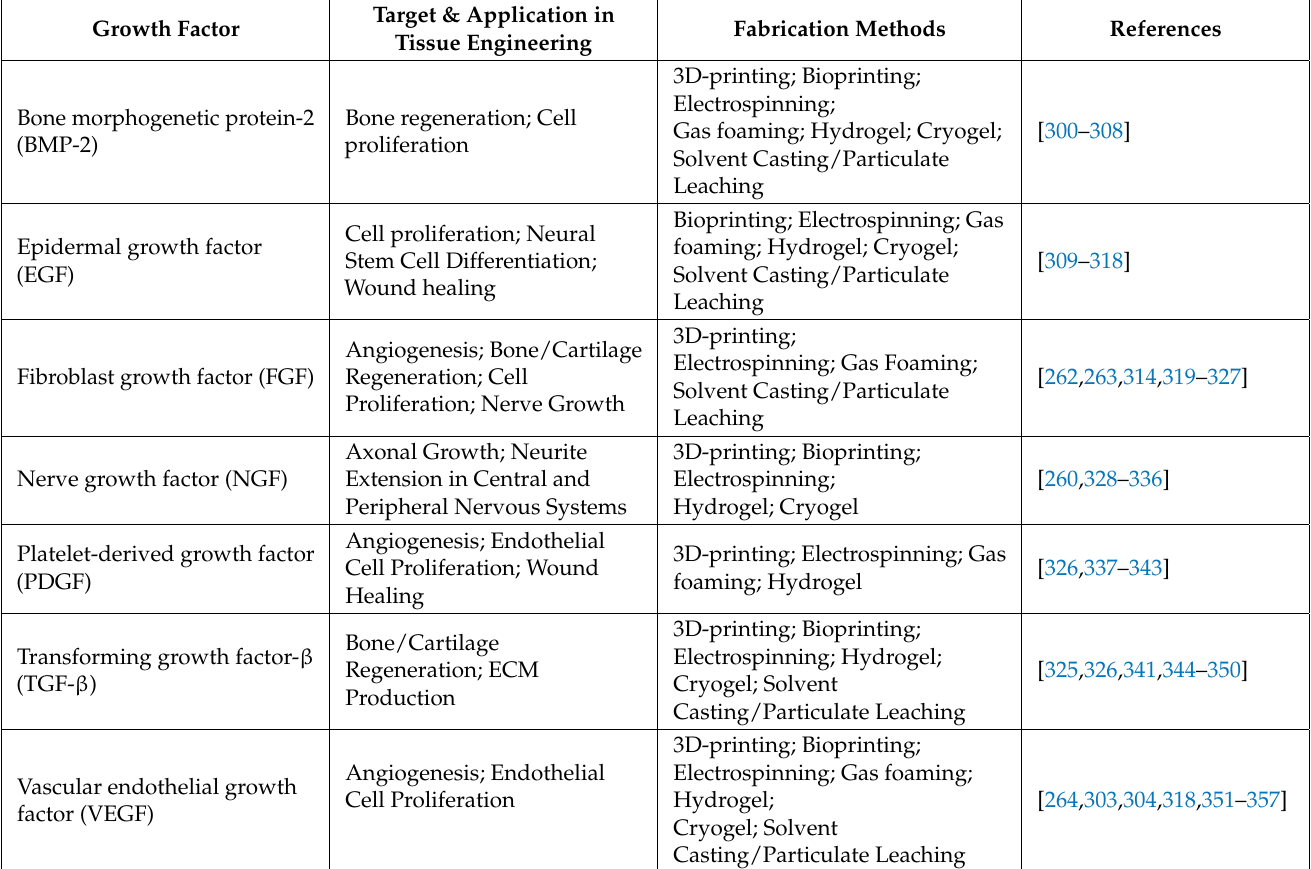
Table 2. Growth factors commonly incorporated in tissue-engineered scaffolds (Adapted from Whitaker, M. et al.